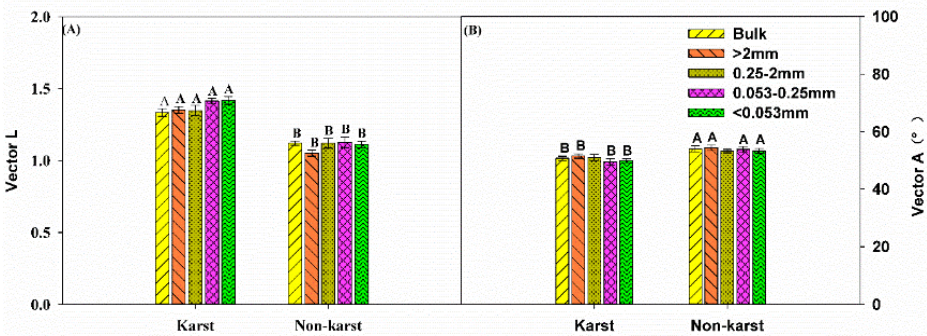
Figure 4. Vector length ( A ) and vector angle (degree) ( B ) between the karst and non-karst forests. Error bars represent the standard deviation. Capital letters indicate differences among the forest ecosystems in the same aggregate size.